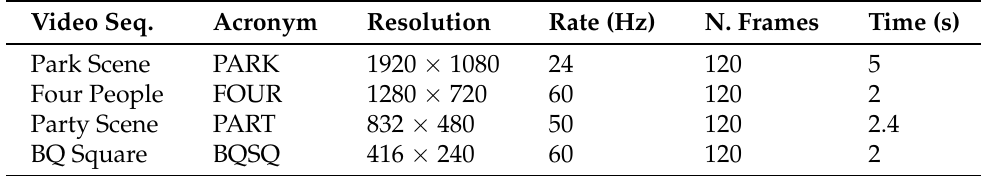
Table 3. Video sequences.